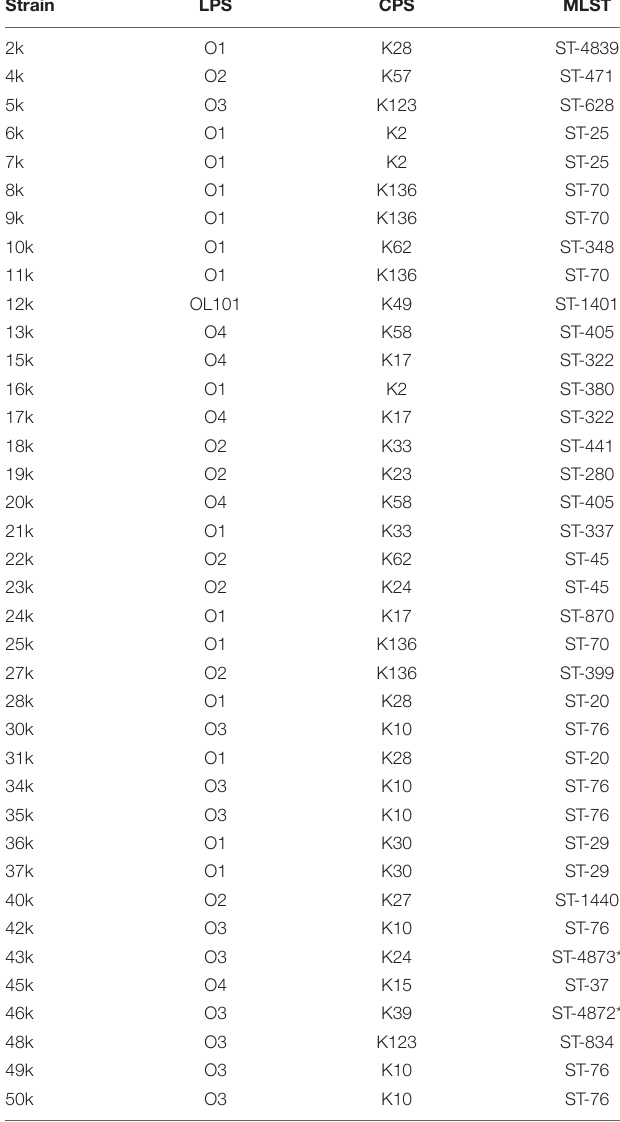
TABLE 4 | Capsular polysaccharide synthesis (CPS), LPS, and MLST in K. pneumoniae strains.